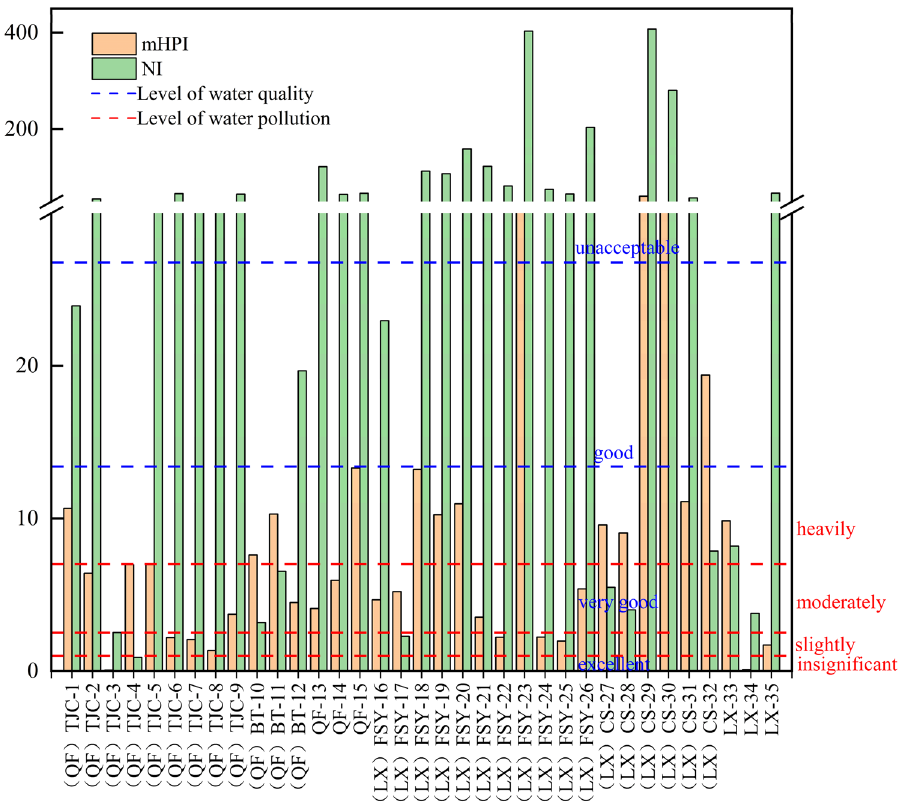
Figure 3. Heavy metal pollution of surface water in XKS based on the NI and